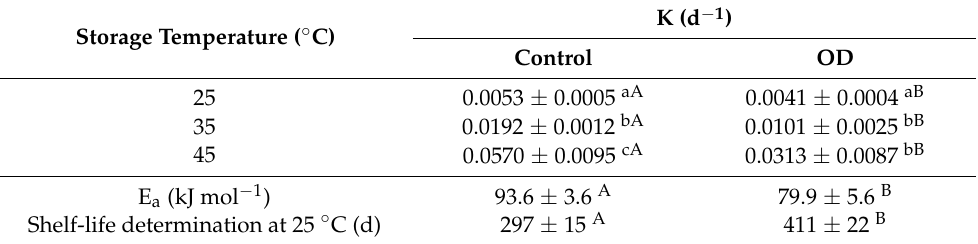
Table 6. Kinetic characteristics of the color change, rate constants k (d − 1 ) and activation energies E a (kJ mol − 1 ) of the control and OD-pretreated dried figs during storage at 25–45 ◦ C and shelf-life determination (d) at 25 ◦